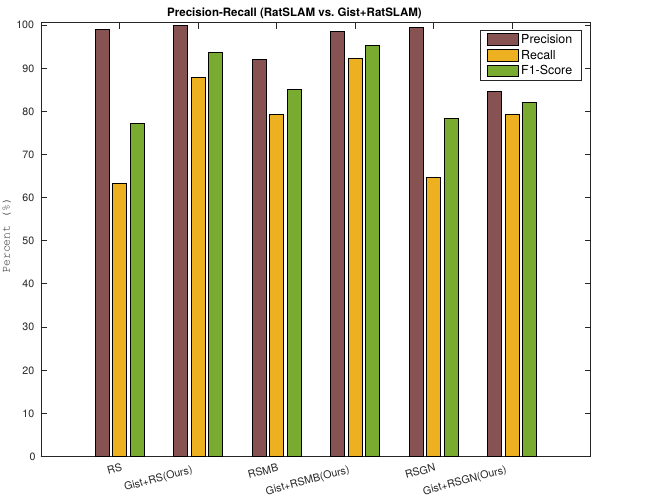
Figure 8: Experience map of the path driven by vehicle. RatSLAM and Gist+RatSLAM are able to detect loop closure and preserve topology of envi- ronment, but Gist+RatSLAM has specifically better convergence as already demonstrated in Section